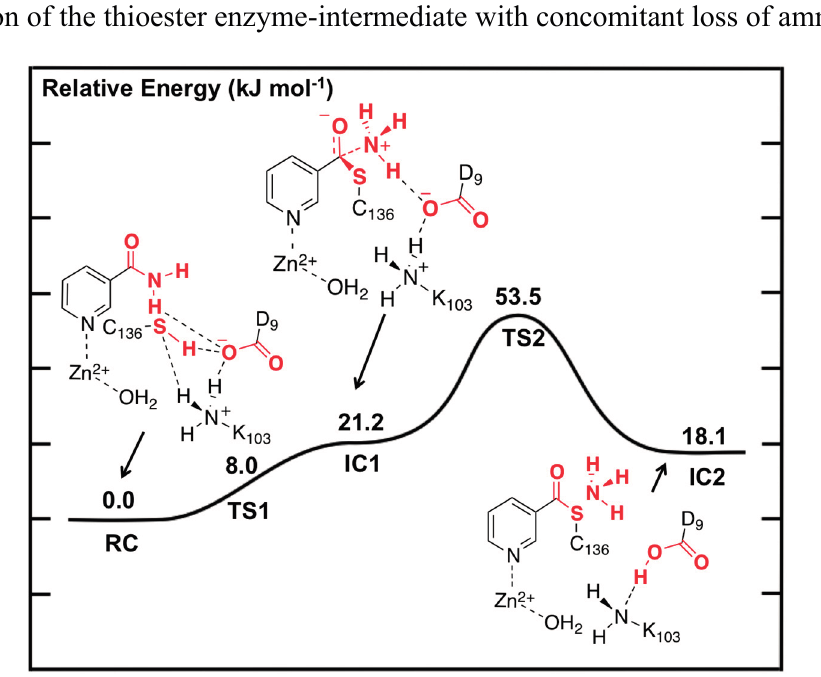
Figure 2. Potential energy surface (kJ·mol − 1 ) obtained at the ONIOM(B3LYP/6- 311+G(2df,p):AMBER96)-EE//ONIOM(B3LYP/6-31G(d):AMBER96)-ME level of theory for formation of the thioester enzyme-intermediate with concomitant loss of